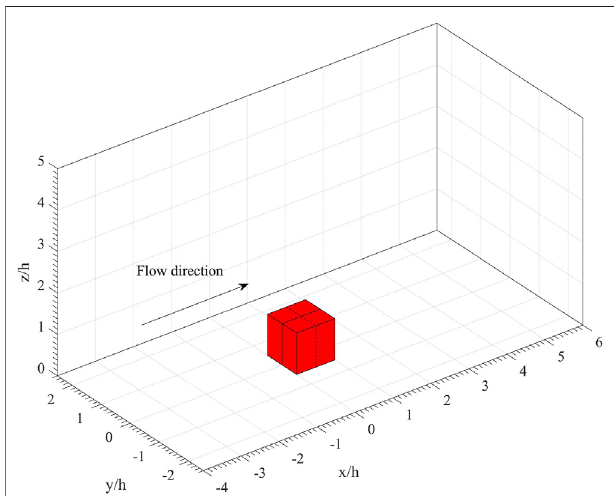
FIGURE 2 | Computational domain 10 h × 5 h × 5 h for the cube height, h (cid:3) 0 . 08 m with a grid resolution of 320 × 160 × 160 used in the model validation against the experimental data of Lim et al. (2009). The axial centerline (solid line) at y / h (cid:3) 0 and the transverse centerline (dashed line) at x / h (cid:3) 0 . 5 are shown.